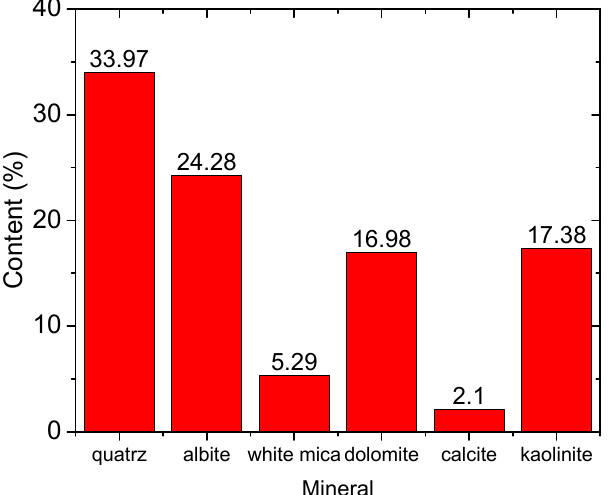
Figure 1. The mineral composition and content of Beizao sandstone.